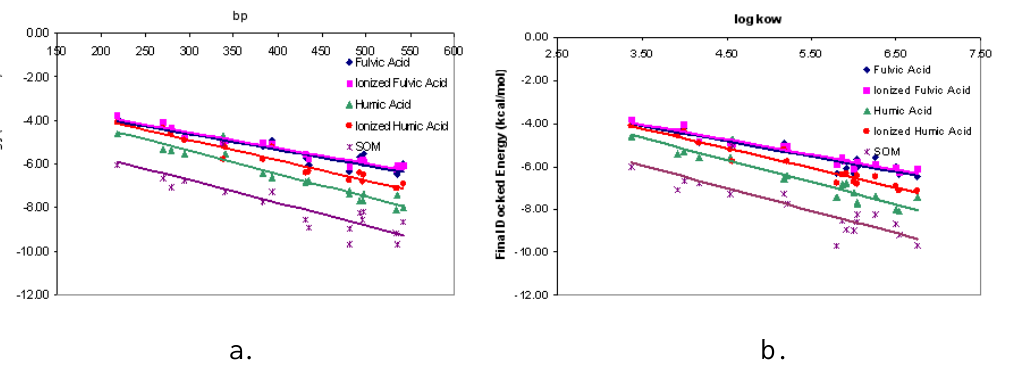
Figure 9 . Plots between two chemical properties (bp (a) and Log K docked energies of PAHs